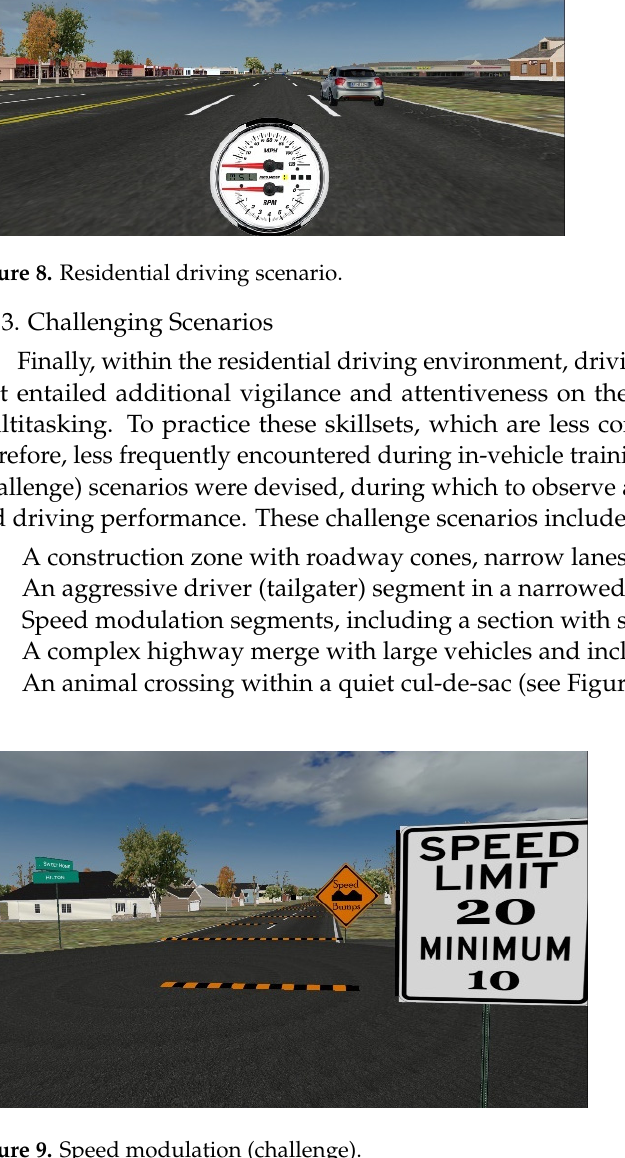
Figure 7. The figure-8 scenario (CC).